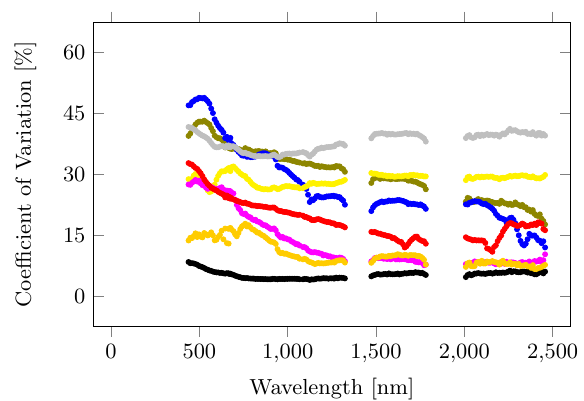
Figure 5. Coefficient of variation spectra for the URBAN-SAT dataset ( Glass : cyan; Concrete : red; Metal : gray; Wood : orange; Fibre Cement : green).